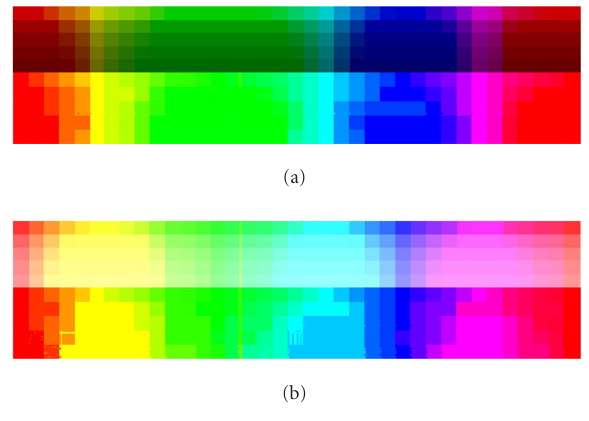
Figure 12: (a) Measured RGB to Hue transformation as a function of intensity (multiplicative shift). (b) Measured RGB to Hue trans- formation as a function of saturation (additive shift).